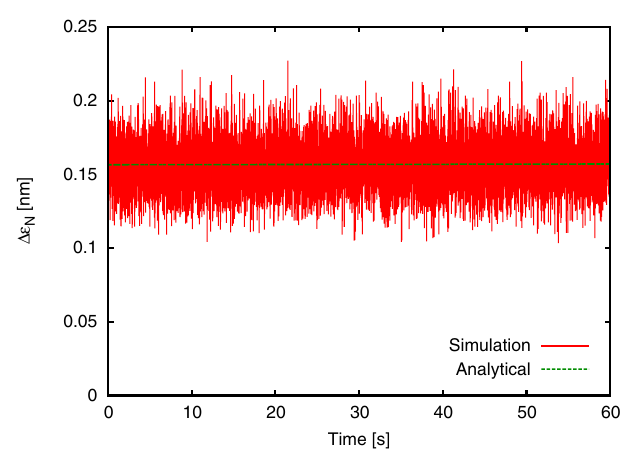
FIG. 27. (Color) Single-pulse emittance growth along the CLIC main linac during 1 min of operation when multipulse optimized feedbacks are used. The result is nearly indistinguishable from what was obtained with feedbacks optimized for single-pulse emittance cf. Figure